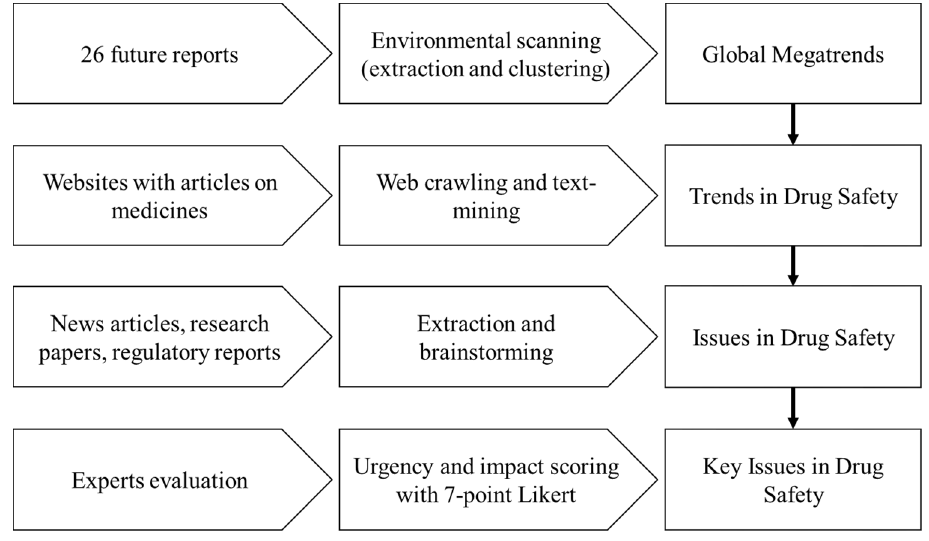
Figure 1. The flow of finding issues in drug safety.